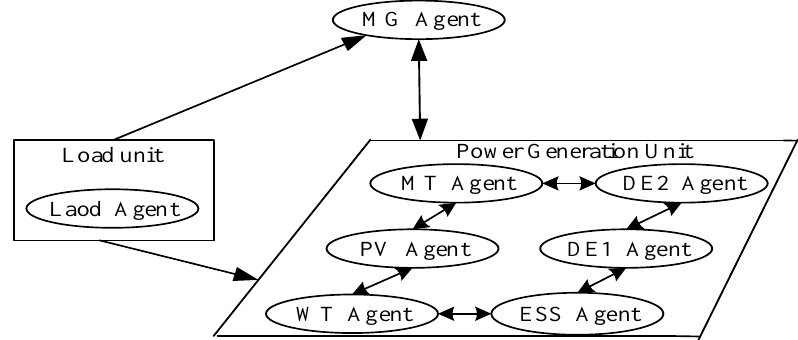
Figure 3. Energy management framework in the microgrid.